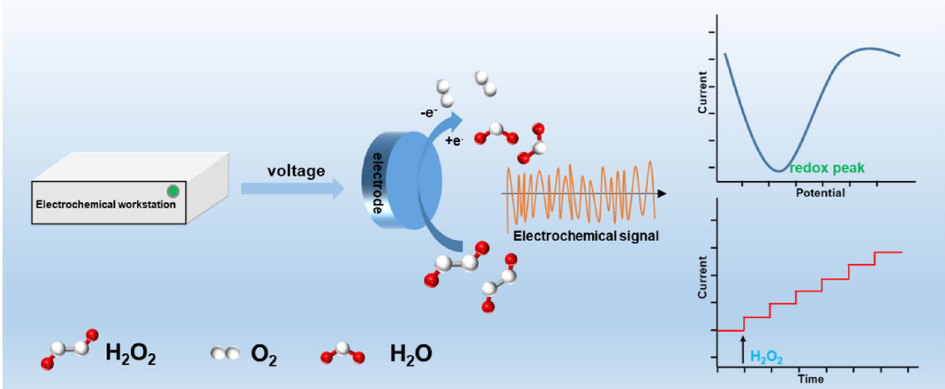
Figure 2. Schematic diagram of H 2 O 2 detection by electrochemical sensor.